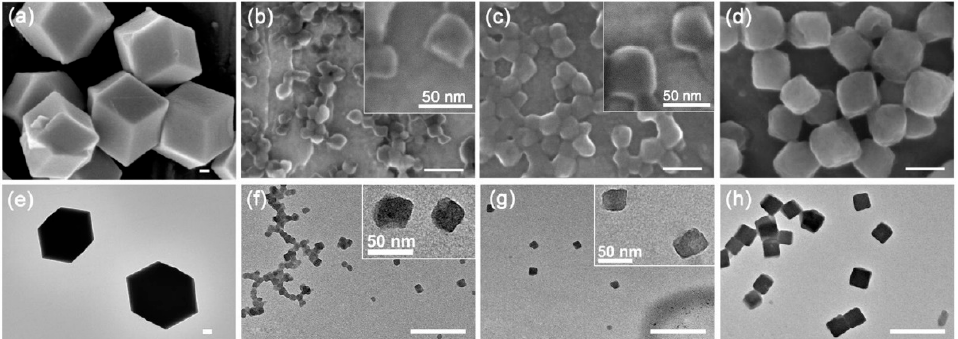
Figure 2. SEM ( a – d ) and TEM ( e – h ) images of the ZIF-8 nanoparticles synthesized in the absence ( a , e ) or presence of RK ( b , f ), K-RK ( c , g ) and RKRK ( d , h ), respectively. The scale bars for the SEM images are 100 nm. The scale bars for the TEM images are 200 nm. The insets of images ( b , c , f , g ) are the corresponding high-resolution images. The peptide concentration is 1.0 mM in all cases.